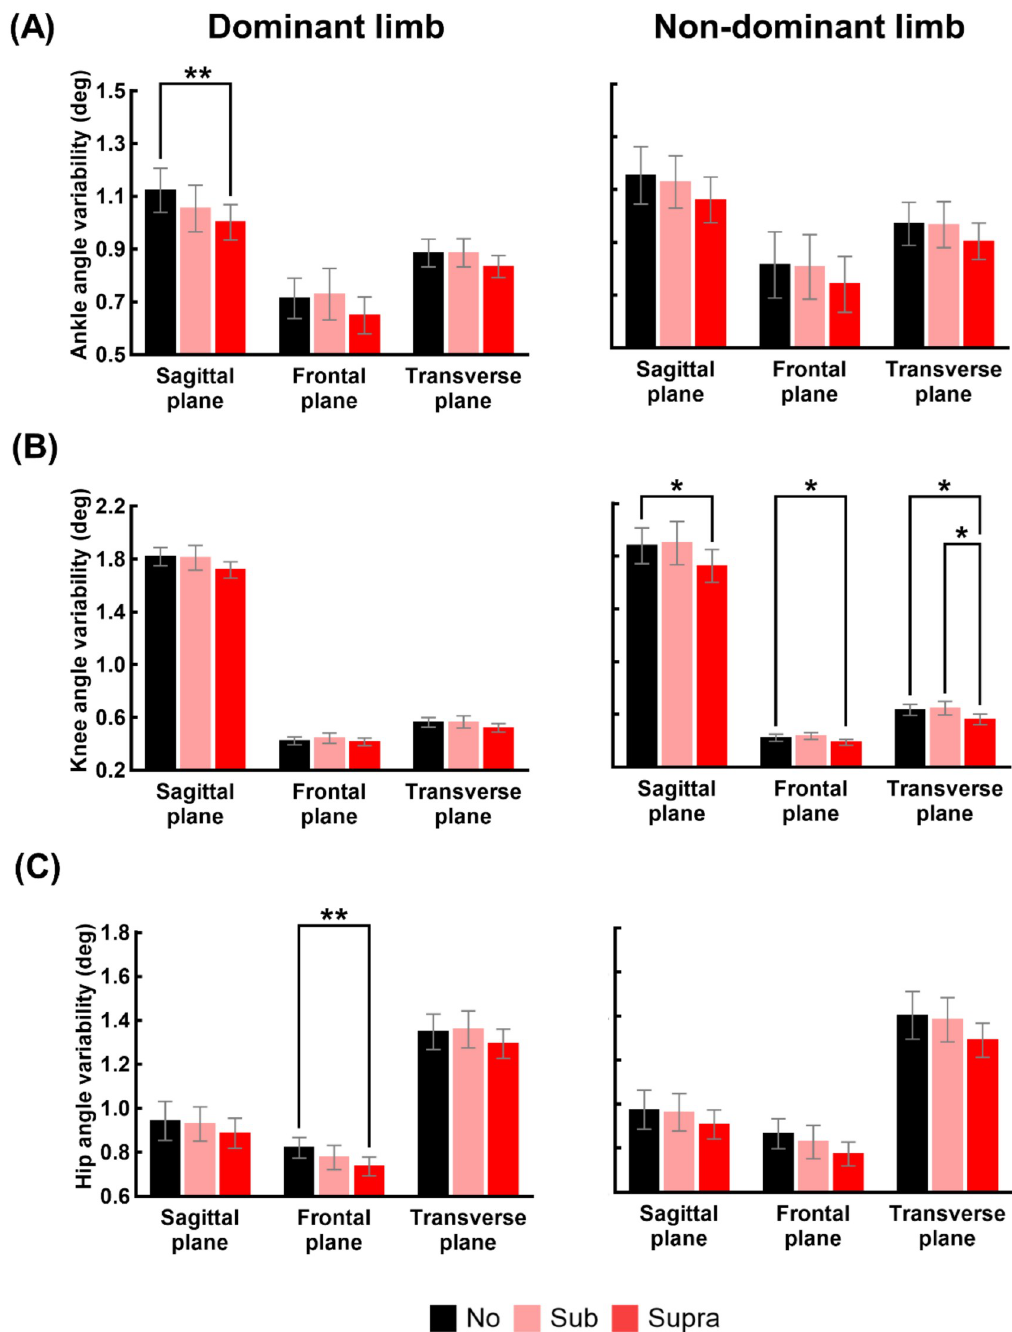
Fig 5. Changes in the variability of lower limb joint angles at MTC due to vibrations. (A-C) show the means and standard errors of the values of the ankle, knee, and hip angles variability at MTC of 17 participants, respectively, for the three vibration levels (No: no vibration, Sub: sub-threshold vibration, and Supra: supra-threshold vibration) and both feet. The double and single asterisk indicate statistically significant difference; �� : p < 0.01, and � : p < 0.05.